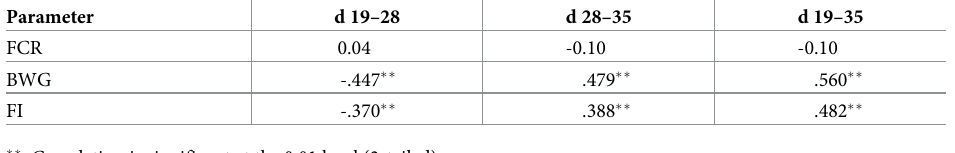
Table 10. Correlations between the independent variables and the covariate male % for each phase for Experiment 4.